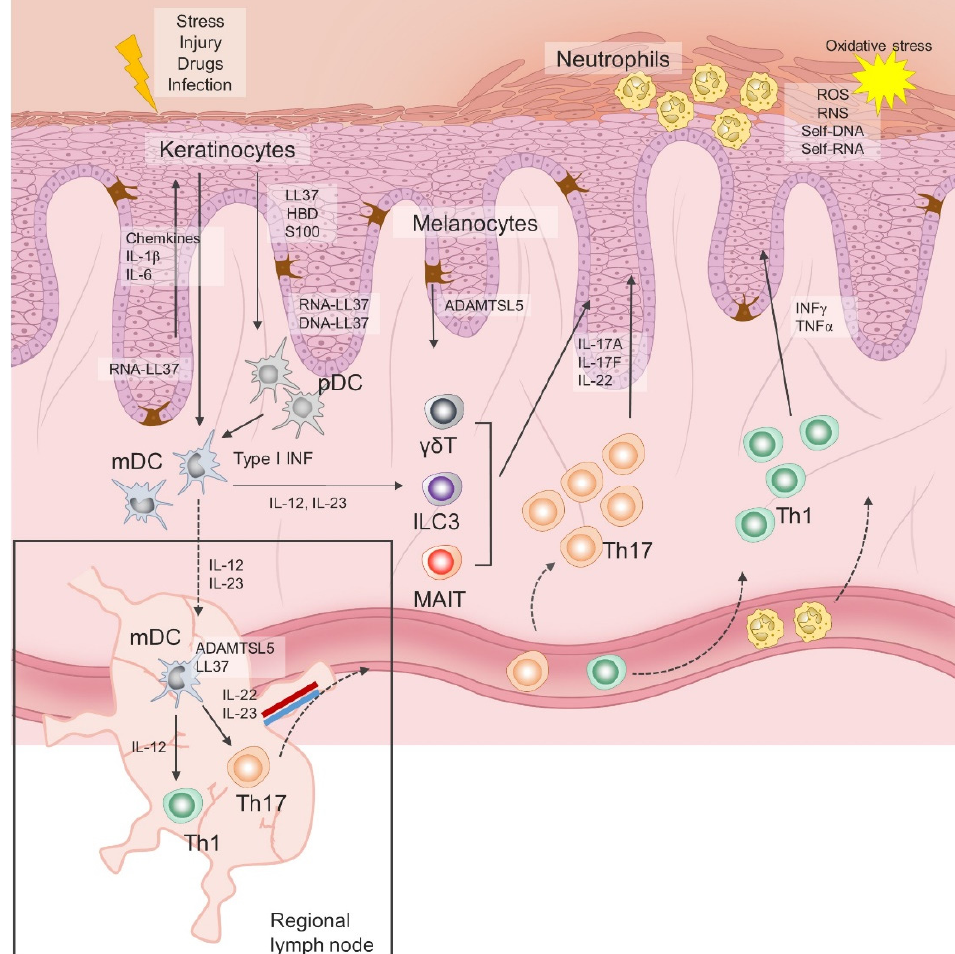
Figure 1. Immunopathogenesis of chronic plaque psoriasis.